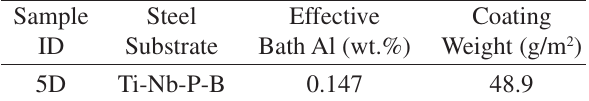
Table 2. Process conditions of the galvanized steel sample (infor- mation provided by the sample